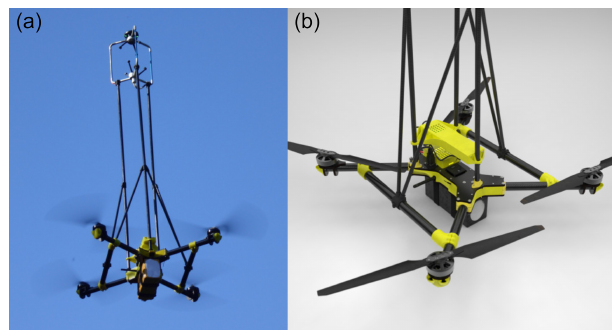
Figure 3. (a) The OPTOkopter drone with a Gill WindMaster on a 1m long mount during a measurement flight. (b) Rendering of the CAD model.